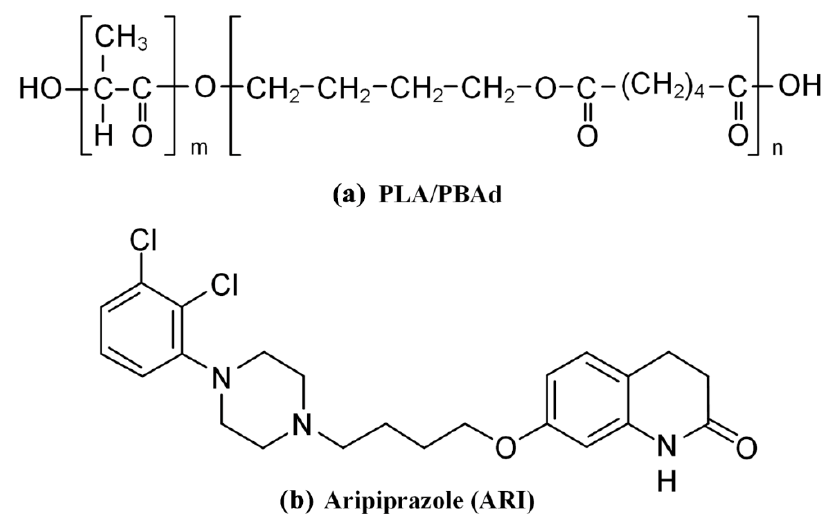
Figure 1. Chemical structures of (a) PLA/PBAd copolymers and (b) aripiprazole (ARI).